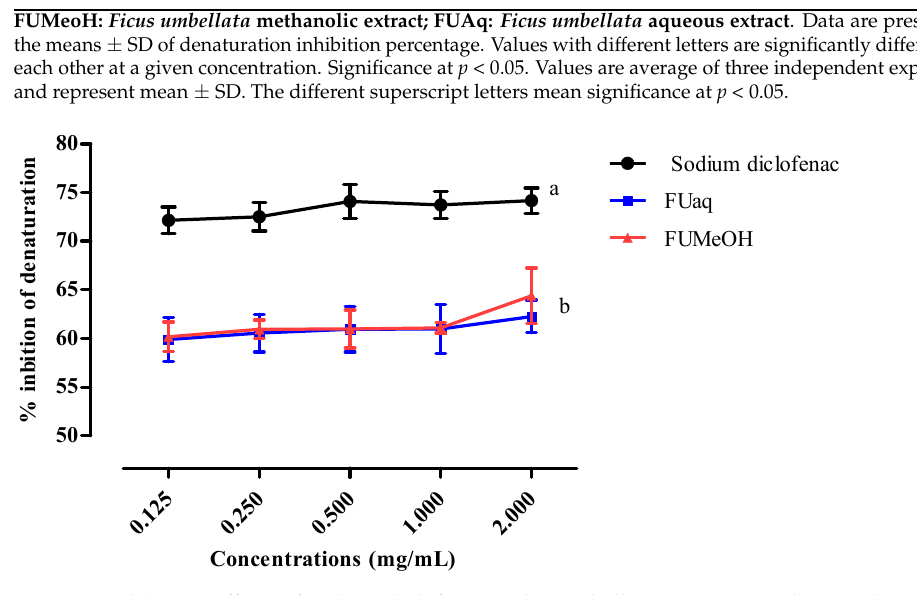
Figure 1. Inhibitory effects of sodium diclofenac and F. umbellatta extracts on albumin denaturation. FUMeoH: Ficus umbellata methanolic extract; FUAq: Ficus umbellata aqueous extract. Data are presented as the means ± SD of denaturation inhibition percentage of three independent experiments. Values with different letters are significantly different from each other at a given concentration. Significance at p <